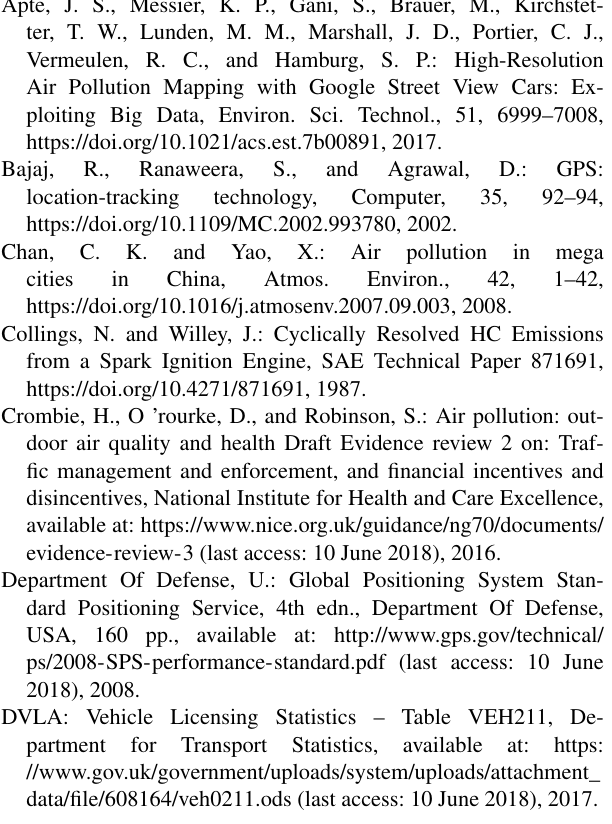
DVLA: Vehicle Licensing Statistics – Table VEH211, De- partment for Transport Statistics, available at: